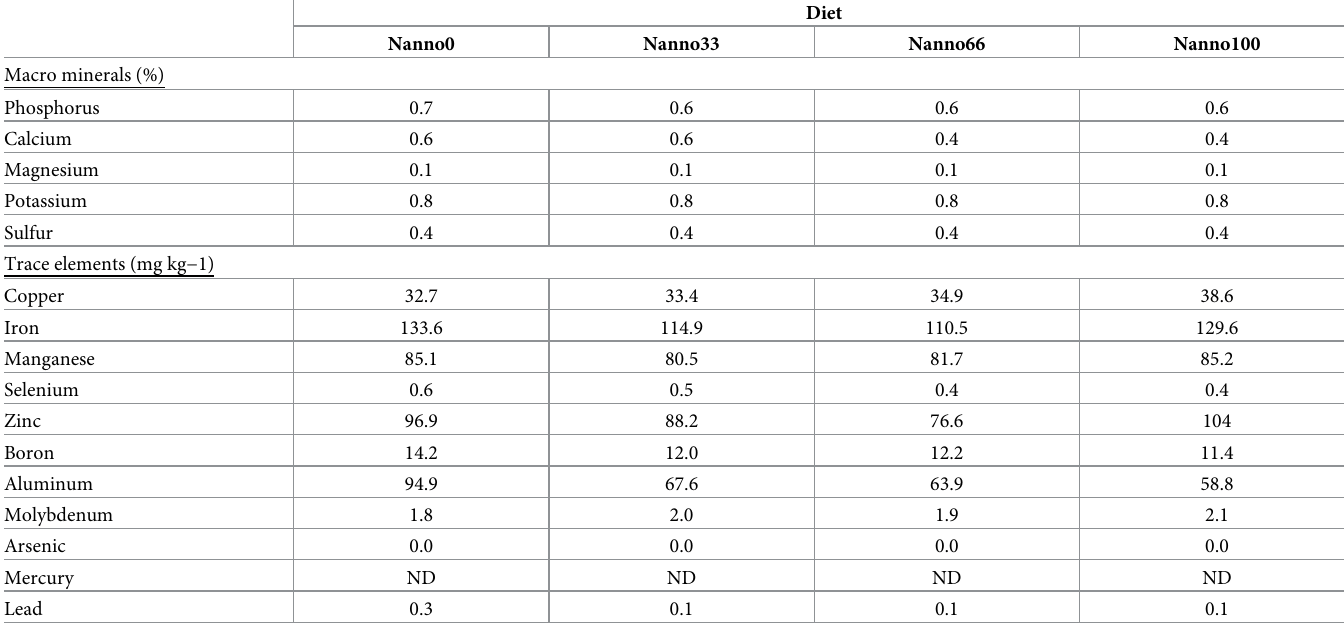
Table 8. Macro minerals and trace elements in the experimental